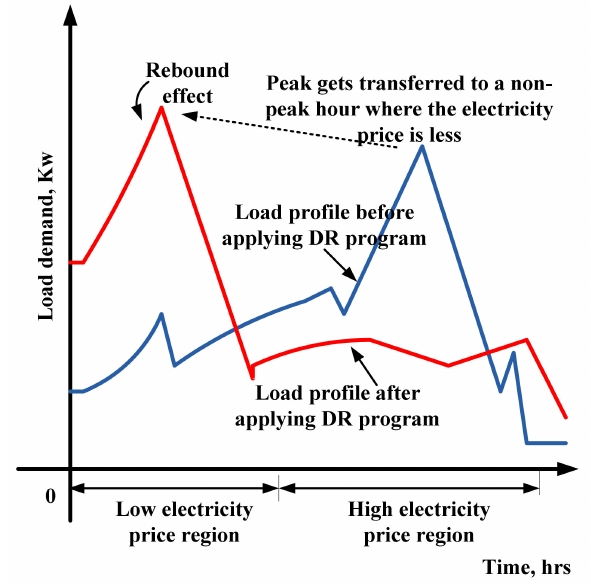
Figure 14. Impact of DR on rebound